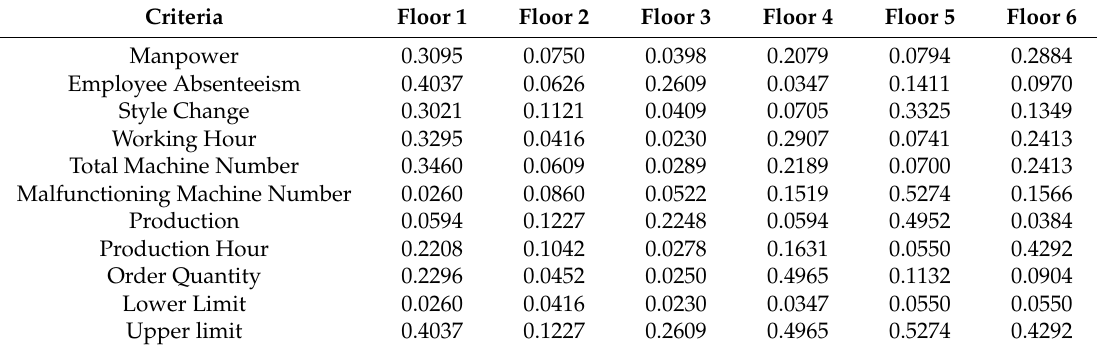
Table 4. Weight of the